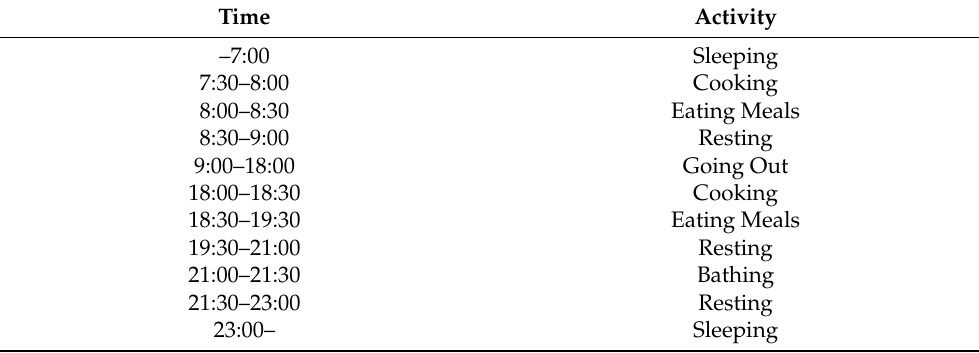
Table 1. Activities